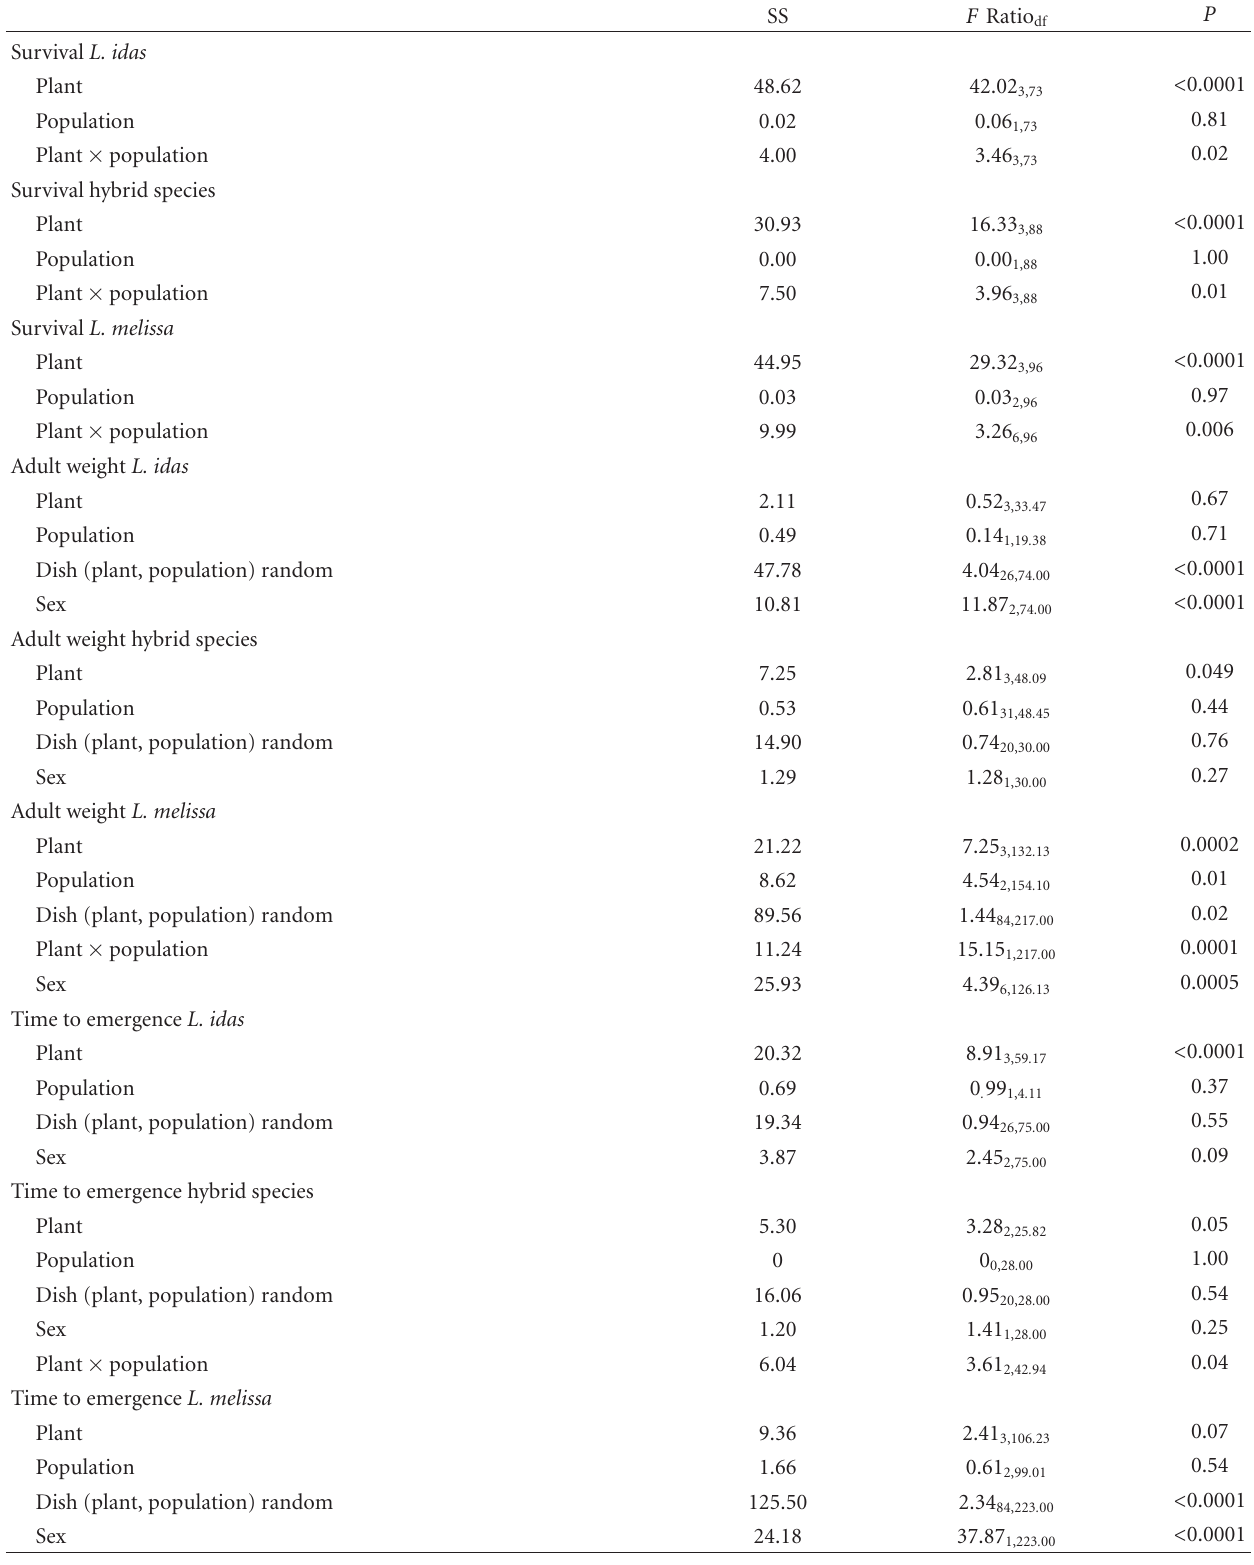
Table 2: Results from analyses of variance for the three measures of performance: percent survival, adult weight, and time to emergence. In all cases dish was used as the unit of replication. Most population/plant combinations had 9 dishes, except for the following: YG/Ac 12 dishes, YG/Ln 12 dishes, YG/Lp 12 dishes, YG/Ms 12 dishes, and all plant combinations for CP and MR had 12 dishes. The total number of dishes was